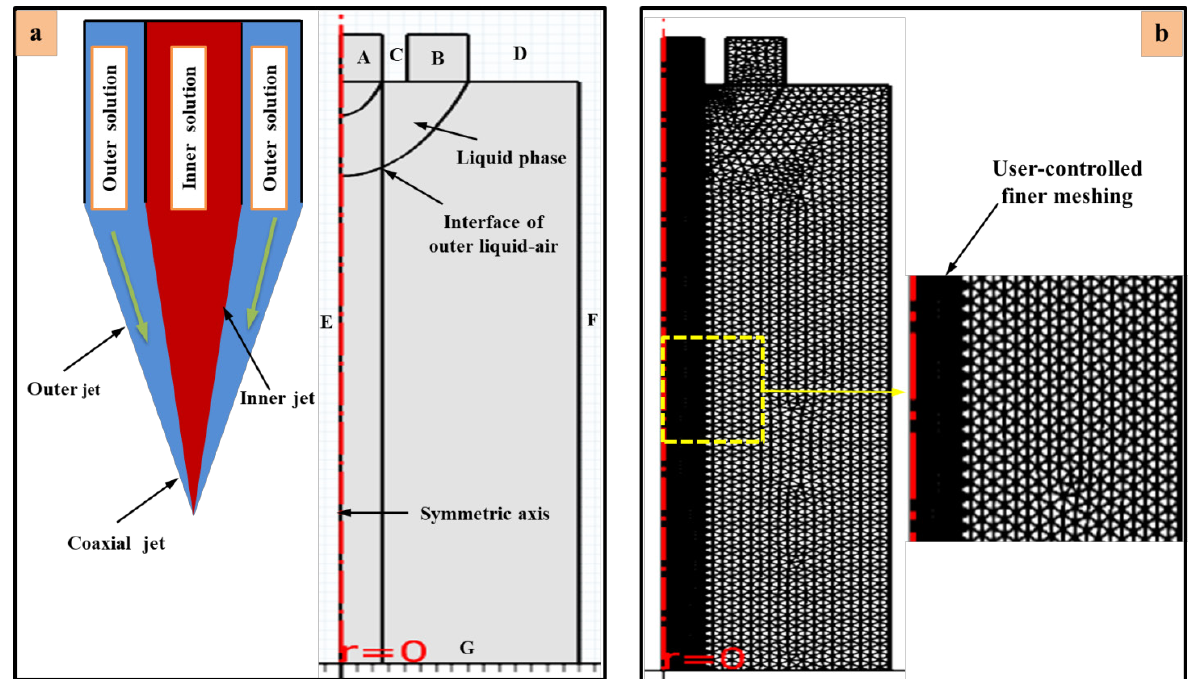
Figure 4. Numerical simulation of DoD CE-Jet printing. ( a ) The geometry of phase field model and particular boundary conditions. ( b ) The finer user-controlled meshing for model .